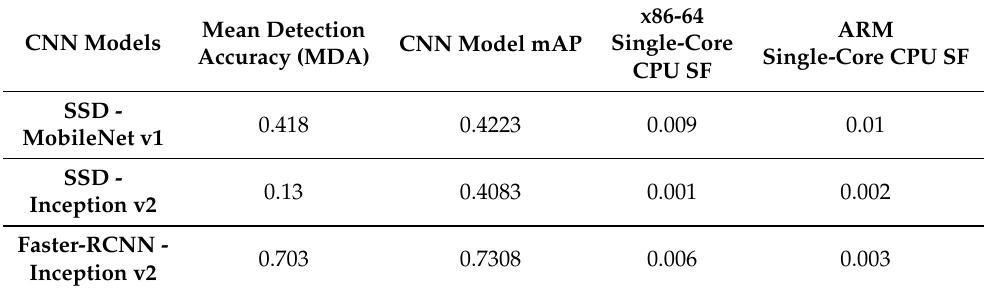
Table 7. Mean detection accuracy (manual bee counting verification) over models’ mAP.